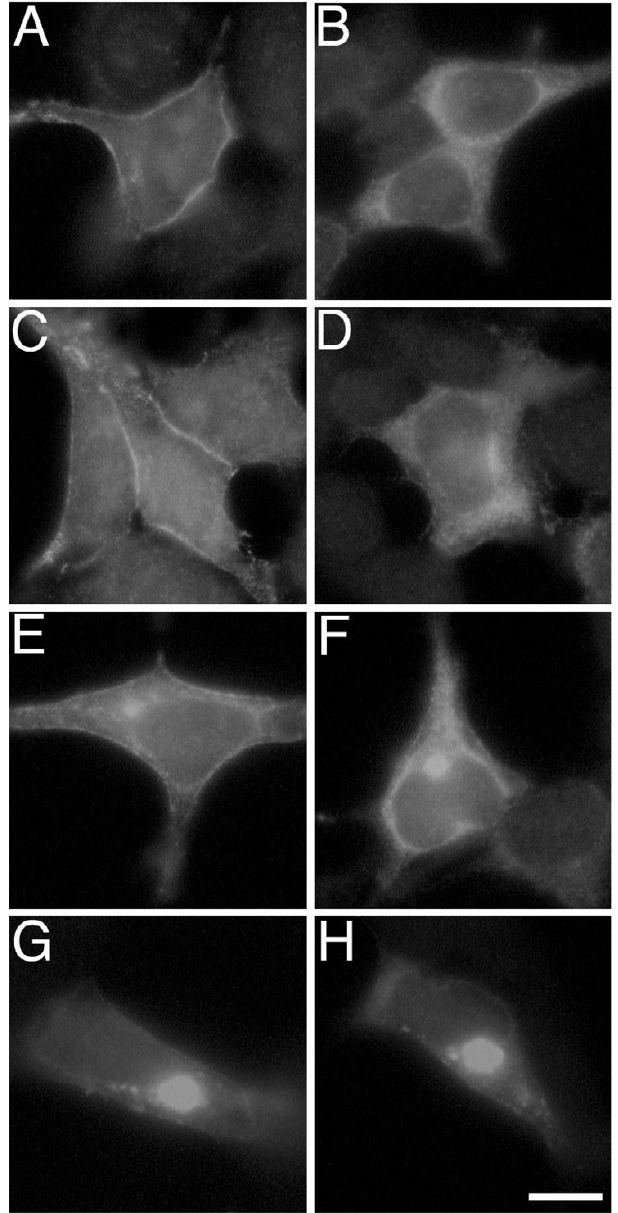
Figure 7 Effect of ALLN on α i2 and s α i2 localization α i2 (A, C, E, and G) or s α i2 (B, D, F, and H) was expressed in BHK cells. 48 h after transfections cells were incubated in the absence (A and B) or presence of 20 µ g/ml ALLN for 1 h (C and D), 4 h (E and F), or 8 h (G and H). Cells were fixed and processed for immunofluorescence using the EE antibody followed by an Alexa 488 conjugate anti-mouse antibody. Bar, 10 µ m.